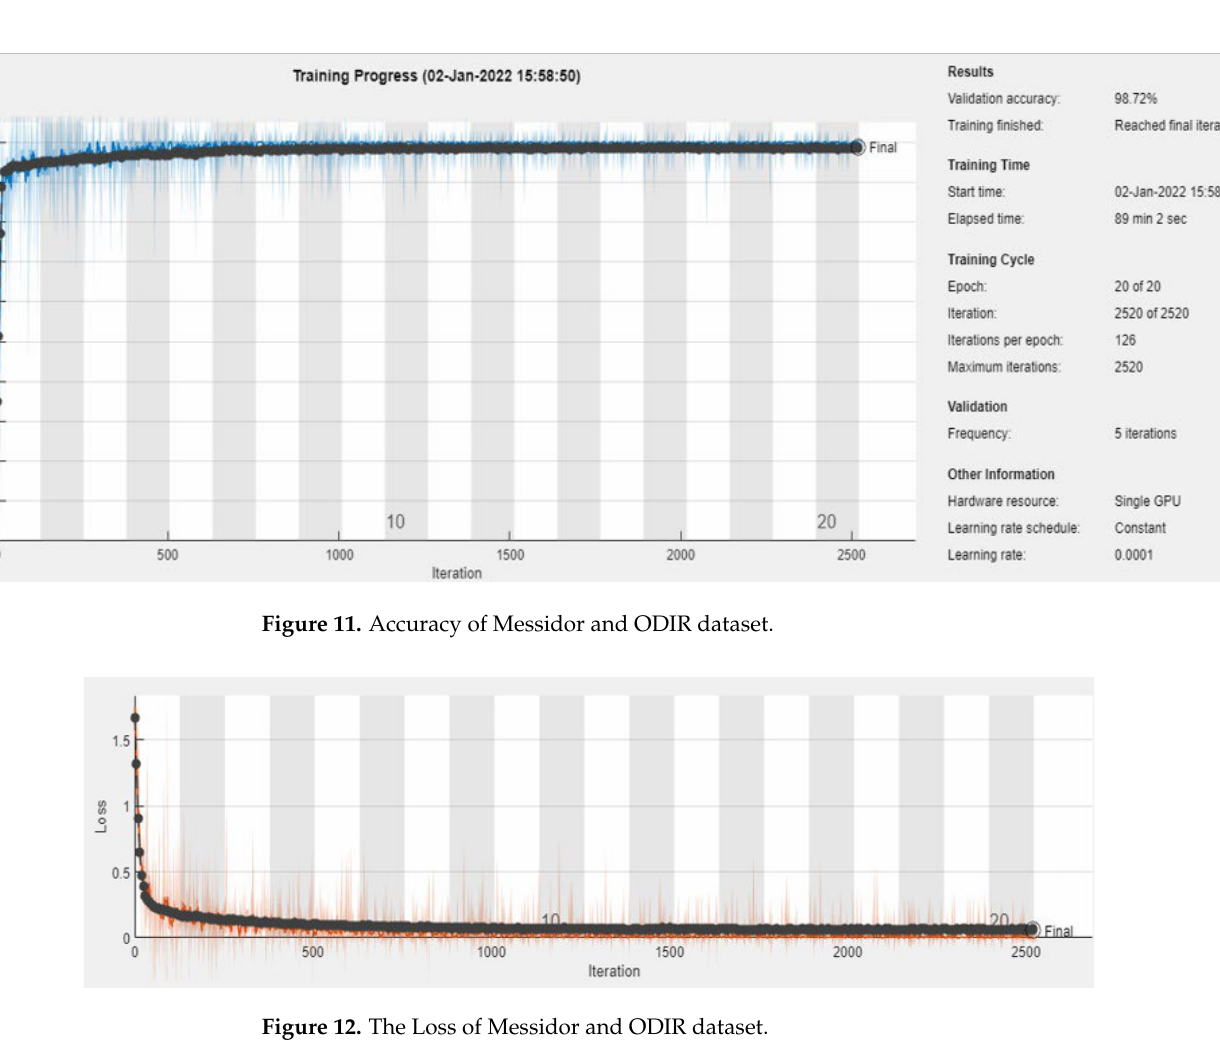
Figure 10. Confusion matrix of MESSIDOR and ODIR datasets.